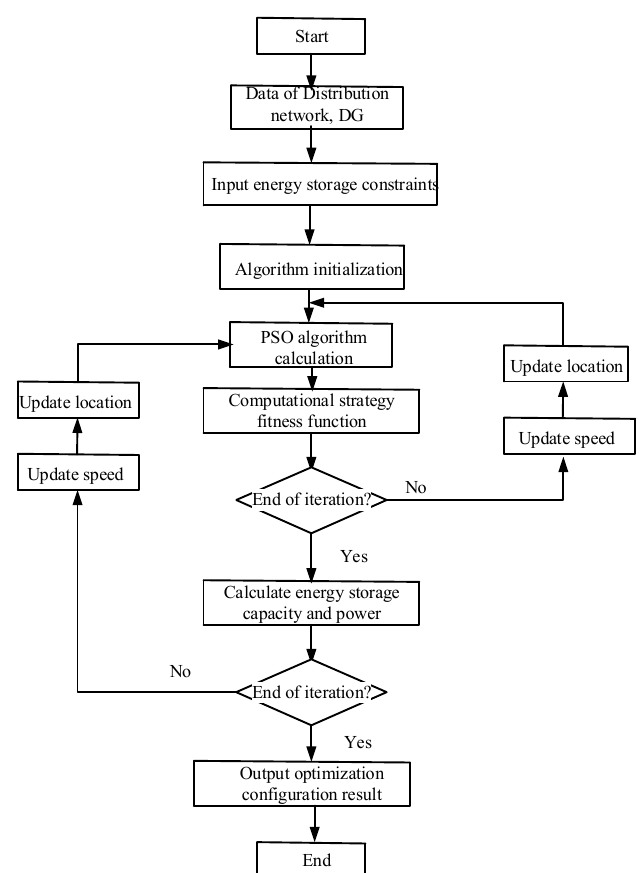
Figure 2. Improved particle swarm optimization algorithm flow.